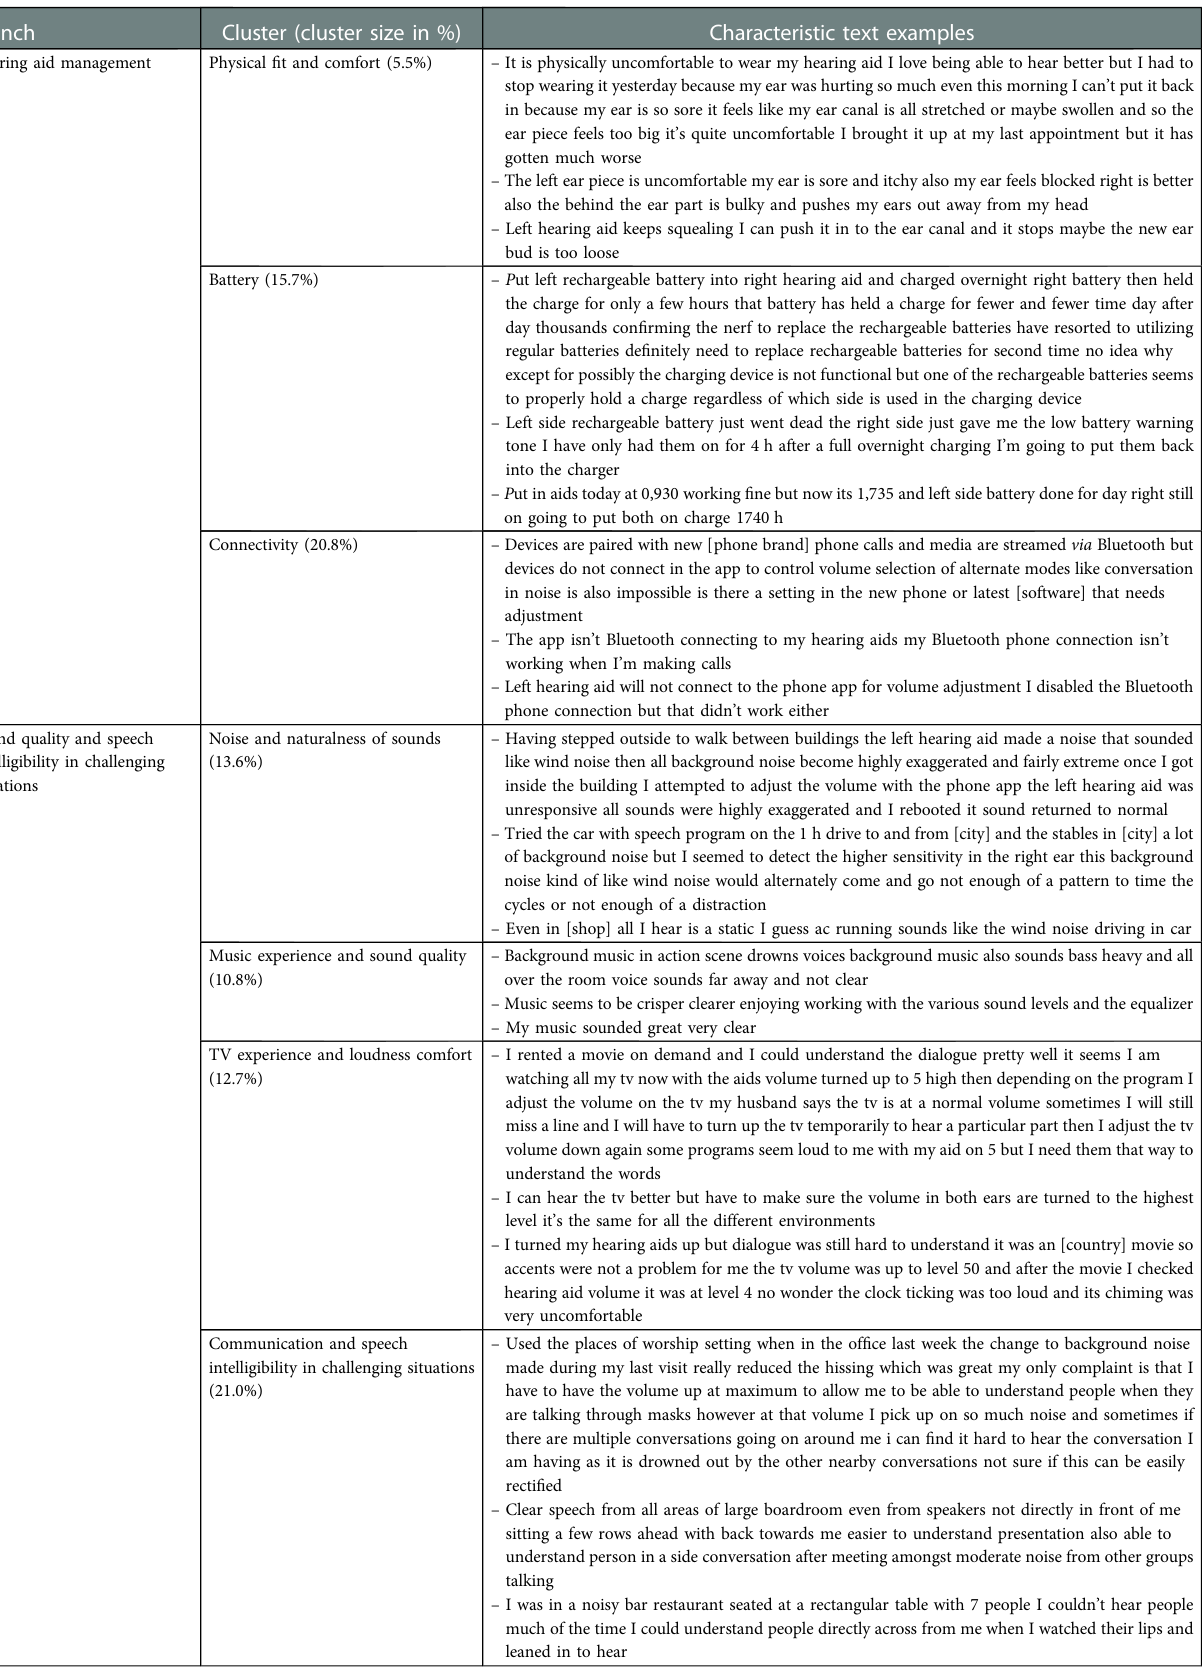
TABLE 1 Top three characteristic texts examples for the resulting clusters, based on the highest χ 2 -values. Each example is an open-text statement provided by one hearing aid wearer during one EMA session.